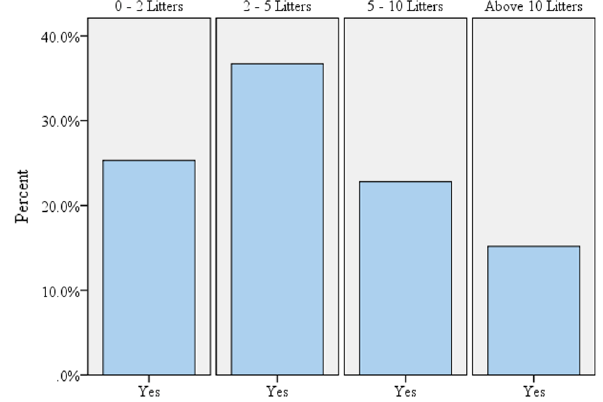
Table 4 Additional water consumption existed in ASTU campus (in liters) after the COVID-19 pandemic